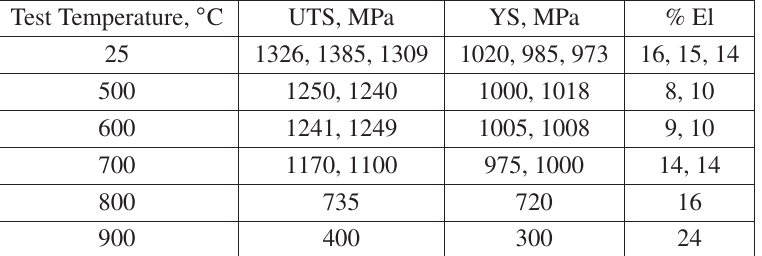
Table 4. Mechanical properties, Ultimate tensile strength (UTS), Yield strength (YS) and % Elongation (% El) of forged and heat treated alloy at different temperatures.